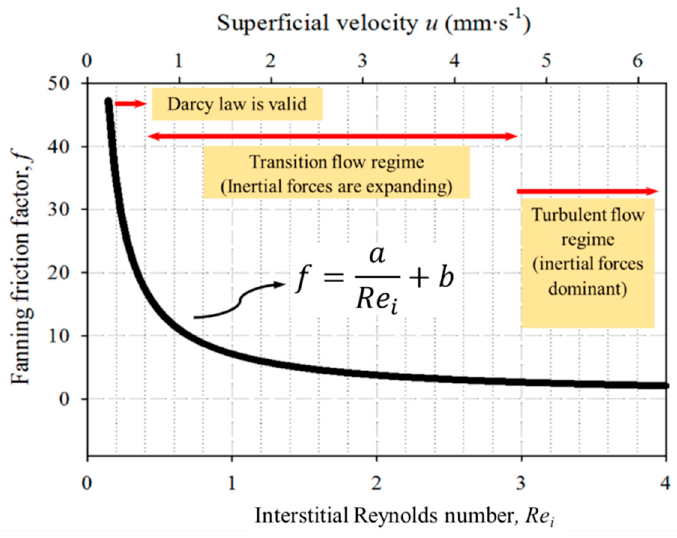
Figure 2. Schematic classi fi cation of the fl ow through a porous medium. Based on reference [17].